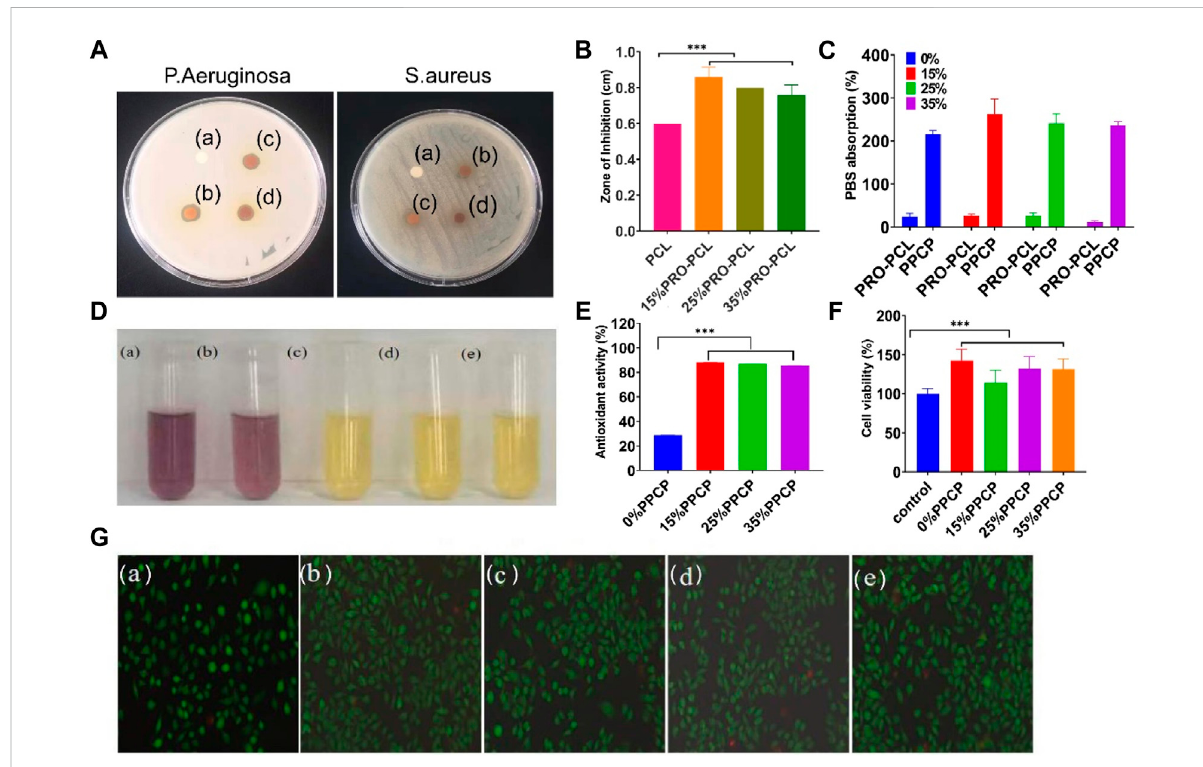
FIGURE 3 Representative graph showing antibacterial, antioxidant activities, and cell culture of various nano fi ber membranes. (A) Photographs of againsting P. aeruginosa and S. aureus (a: PCL; b: 15% PRO-PCL; c: 25% PRO-PCL; d: 35% PRO-PCL); (B) Diameter of inhibition zones of various membranes against Pseudomonas aeruginosa (Mean ± SD, n = 3, ** p < 0.01); (C) PBS absorption of various membranes (Mean ± SD, n = 3, *** p < 0.001); (D) Photographs of DPPH solution before and after reaction. (a: DPPH solution. b, c, d and e DPPH solution in which 0%, 15%, 25%, and 35%PPCPnano fi bercompositemembranes). (E) Antioxidantactivityofcompositemembrane(Mean±SD, n =3,*** p < 0.001). (F) Cytocompatibility analysis of various composite membrane (Mean ± SD, n = 3, *** p < 0.001). (G) Live/Dead staining fl uorescent images of mouse-derived fi broblast (L929) cell after treated with composite membrane (a: control, b: 0% PPCP, c: 15% PPCP, d: 25% PPCP, e: 30%